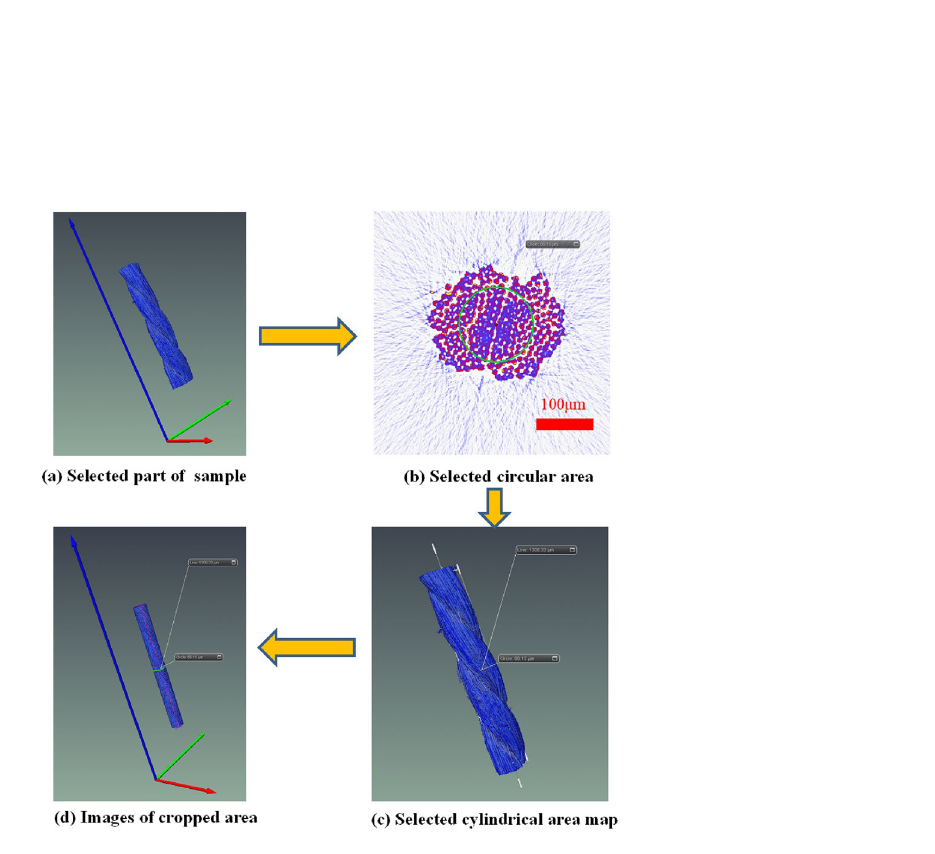
Figure 7. Area selection from the nylon CT